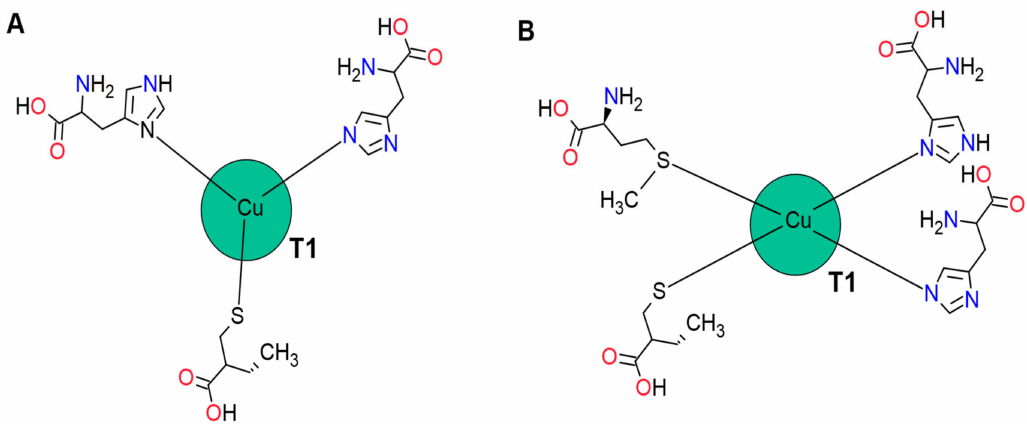
Figure 2. Coordination of ligand in T1 copper. ( A ) Coordination of copper and fungal laccases (tri-coordination). ( B ) Tetra- coordination in non-fungal